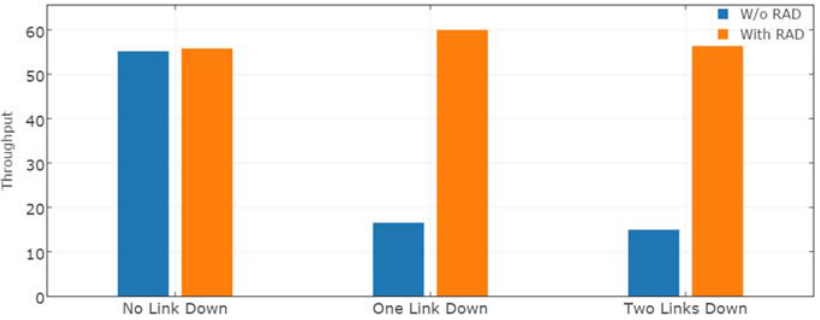
Figure 8. Throughput vs. the number of links down.